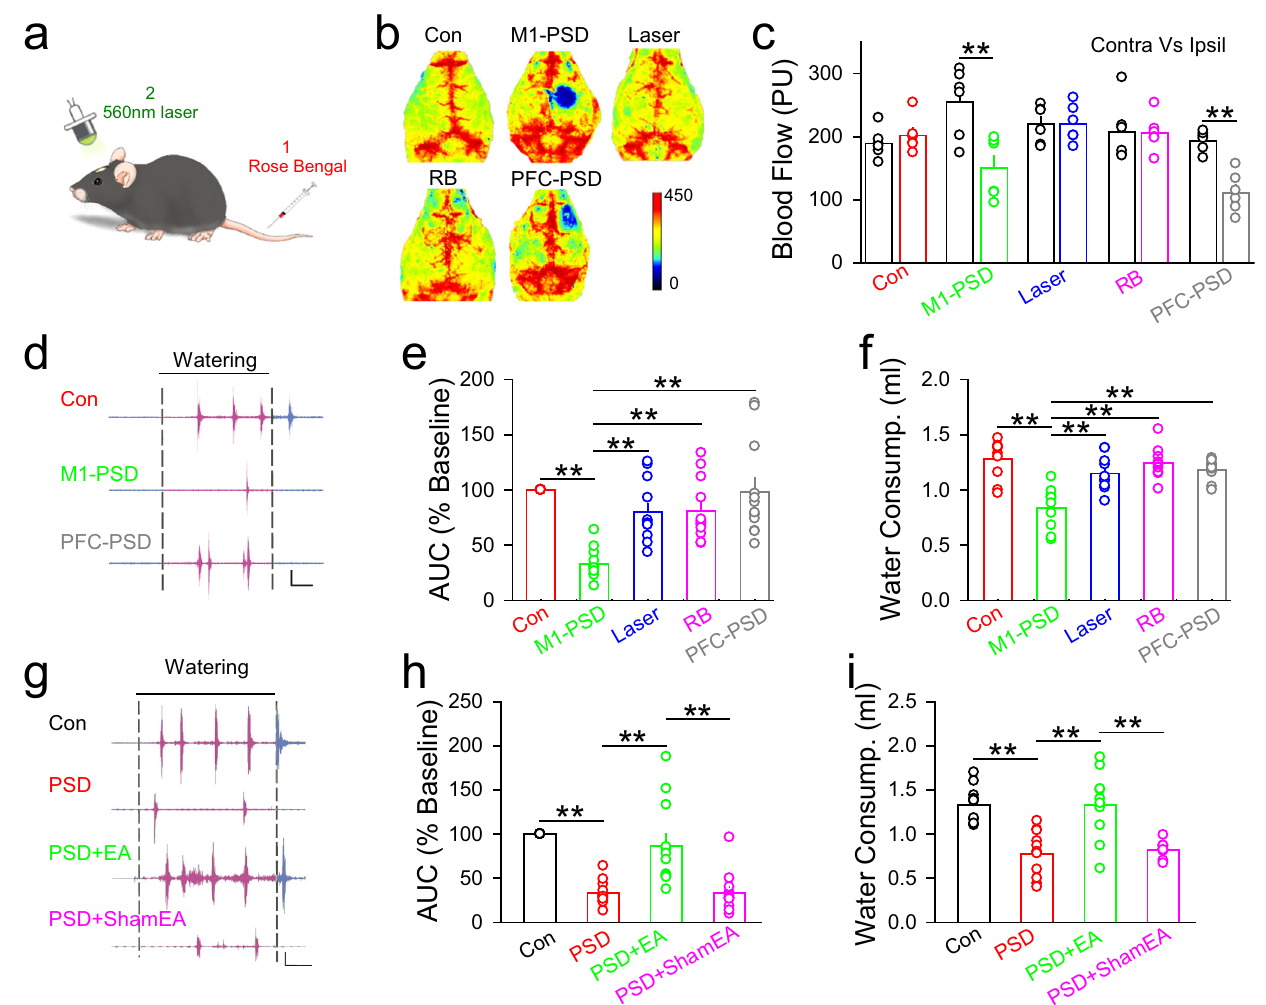
Fig. 2 | EA-CV23 improvedswallowing functionin a mousemodelofdysphagia inducedbyunilateralphotothromboticischemiaintheM1.a Thestrategyused to induce ischemia in mice. RB (15mg/ml, RB) was intraperitoneally injected, and then a 560nm laser was used to focally stimulate the M1. b Representative laser specklecontrastimagesofthromboticinfarctioninthedifferentgroups,including the control (Con), M1 ischemia (M1-PSD), laser illumination only (Laser), RB only andPFCischemia(PFC-PSD)groups. c Bloodperfusioninthecontralateral(Contra) and ipsilateral (Ipsil) brain hemispheres after treatment in the different groups (one-way ANOVA, N =6 per group; F =7.529, **P <0.01). d , e Representative traces of water-induced EMG responses in the different groups, including the Con, M1- PSD,andPFC-PSDgroups.Blacksolidline:durationofwaterdelivery.Blackdashed lines: the start and end of water delivery. Scale bar, 2s and 0.5mV ( d ). Water- induced EMGresponses decreased signi fi cantly inM1-PSDgroup,compared to the